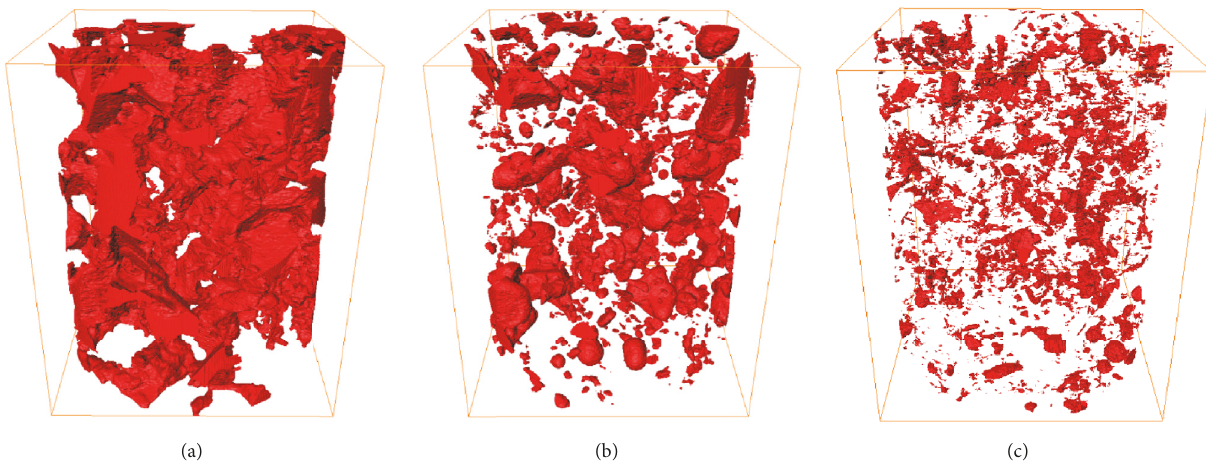
Figure 10: The characteristics of remaining oil during the plug-flood experiment in oil-wet plug. (a) Exp. number 8; (b) Exp. number 9; (c) Exp. number 10.